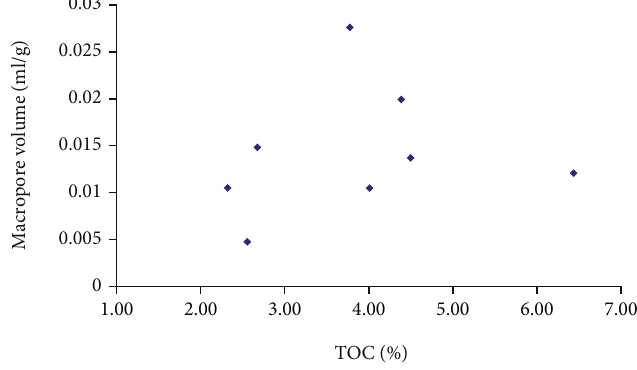
Figure 8: The relationship between the TOC and the macropore volume.